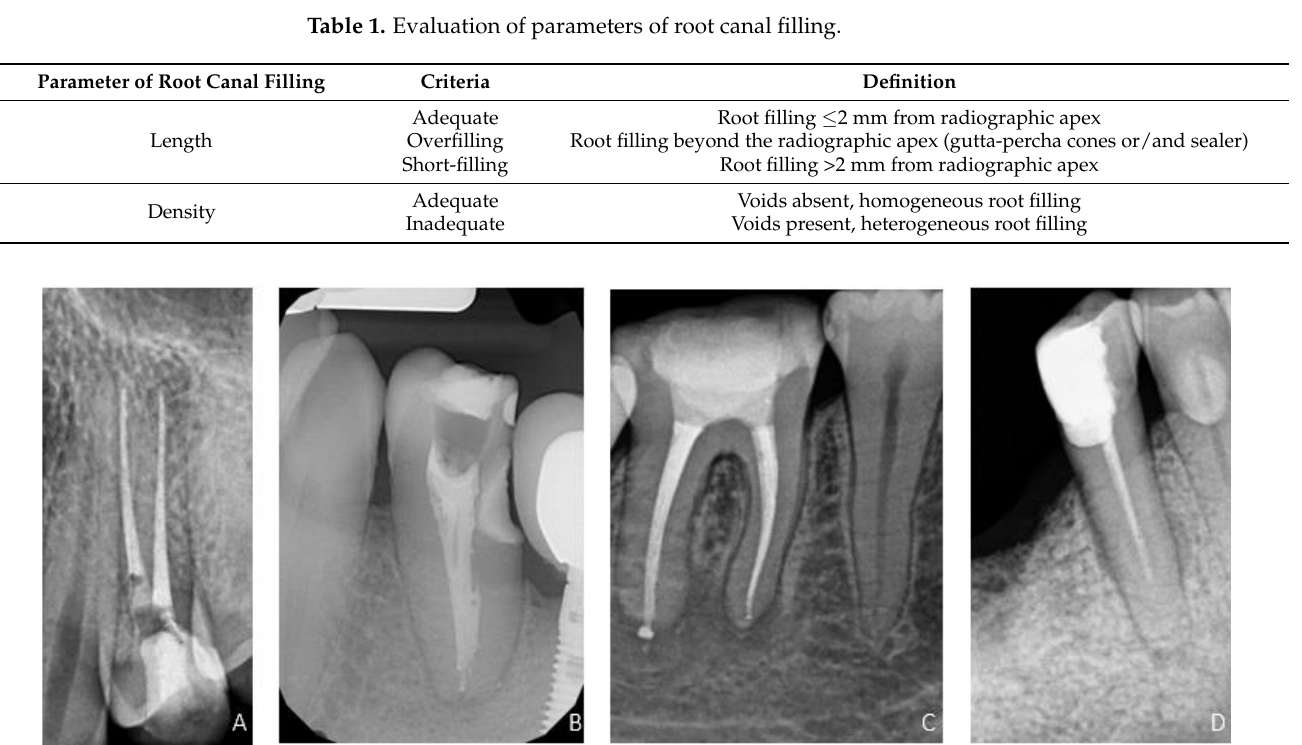
Figure 1. RVG images showing evaluation parameters. ( A ) Adequate length and density, ( B ) Inad- equate density, ( C ) Overfilling, ( D ) Short-filling.